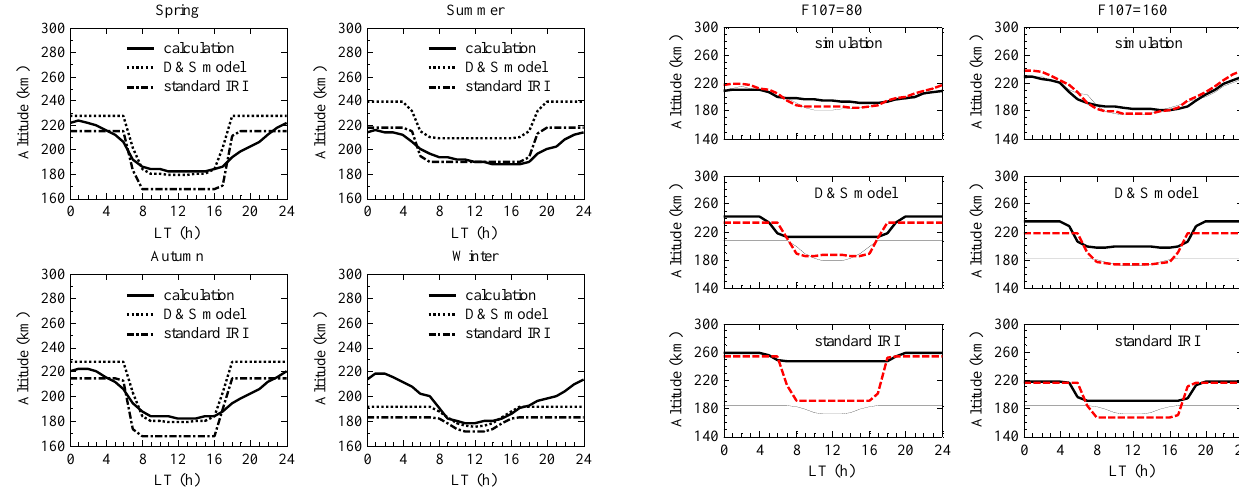
Figure 3. Diurnal variation of the lower transition height as given by the simulated results, the Figure 4. Seasonal effect shown by the simulated LTH and the IRI model (standard IRI and D&S Fig. 4. Seasonal effect shown by the simulated LTH and the IRI Fig. 3. Diurnal variation of the lower transition height as given by model (standard IRI and D&S model) at two solar activity levels: standard IRI and D&S model (Danilov and Simirnova, 1995) for four seasons under F107=100 the simulated results, the standard IRI and D&S model (Danilov and model) at two solar activity levels: left panel for F107=80, and right panel for F107=160. Heavy left panel for F107=80, and right panel for F107=160. Heavy solid Simirnova, 1995) for four seasons under F107=100 and A p =10. and Ap=10. solid lines for summer, dash lines for equinox, and light solid lines for winter. lines for summer, dash lines for equinox, and light solid lines for